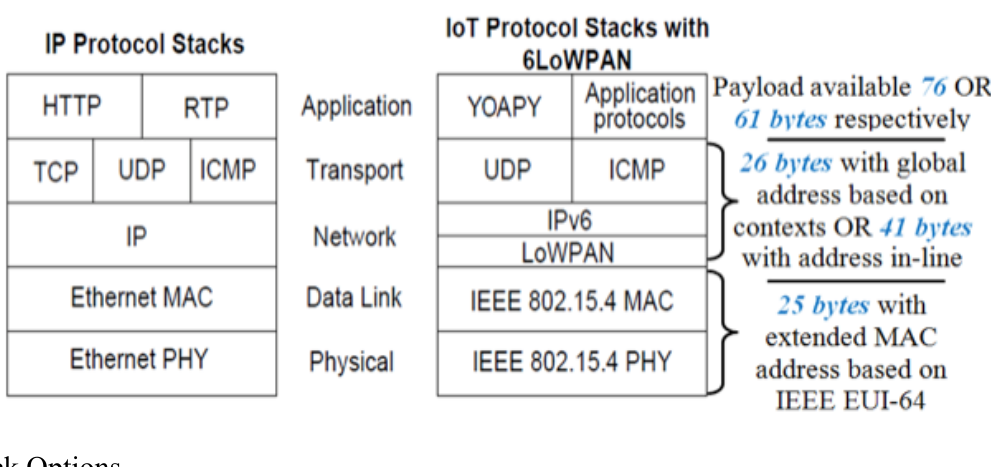
Figure 19. Future Internet of Things Stack (IPv6 &